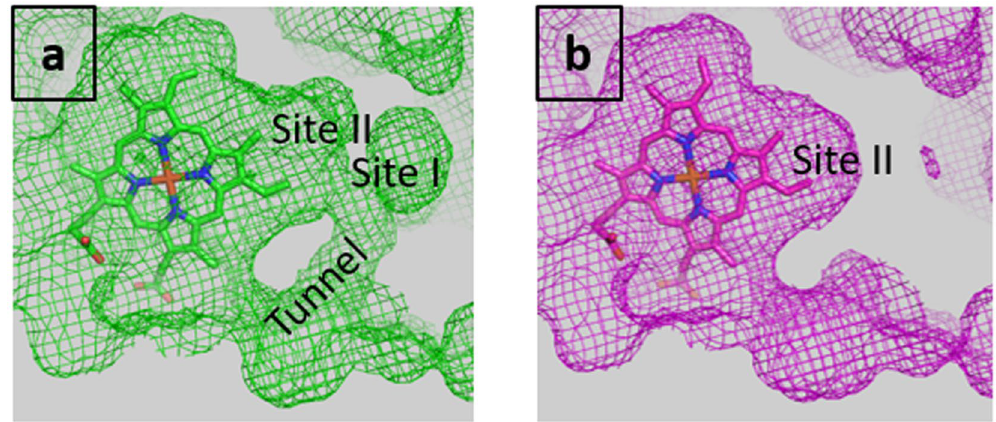
Figure 4. Surface of WT Ngb shown in mesh representation, with the heme shown in stick. (a) WT AP. (b) WT